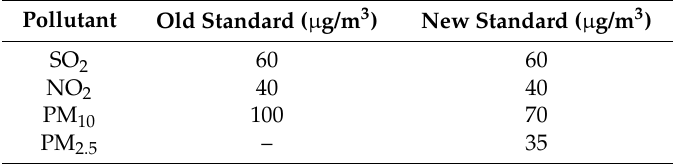
Table 1. Annual average concentration limits (Class II) as regulated in the standard. Pollutant Old Standard ( µ g/m 3 ) New Standard ( µ g/m 3